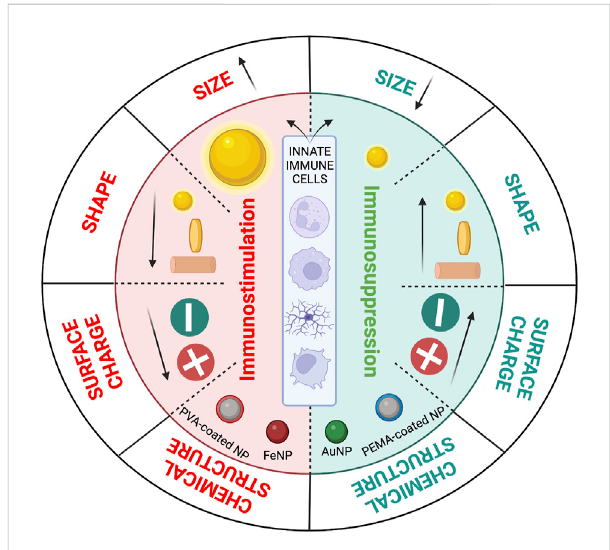
The effect of different nanoparticle design parameters on immune system response. Nanoparticles ’ size, shape, surface charge, and chemical structure can lead to immunogenic or immunosuppressive responses from innate immune cells (from top to bottom: neutrophils, macrophages, microglia, and dendritic cells) (Created in